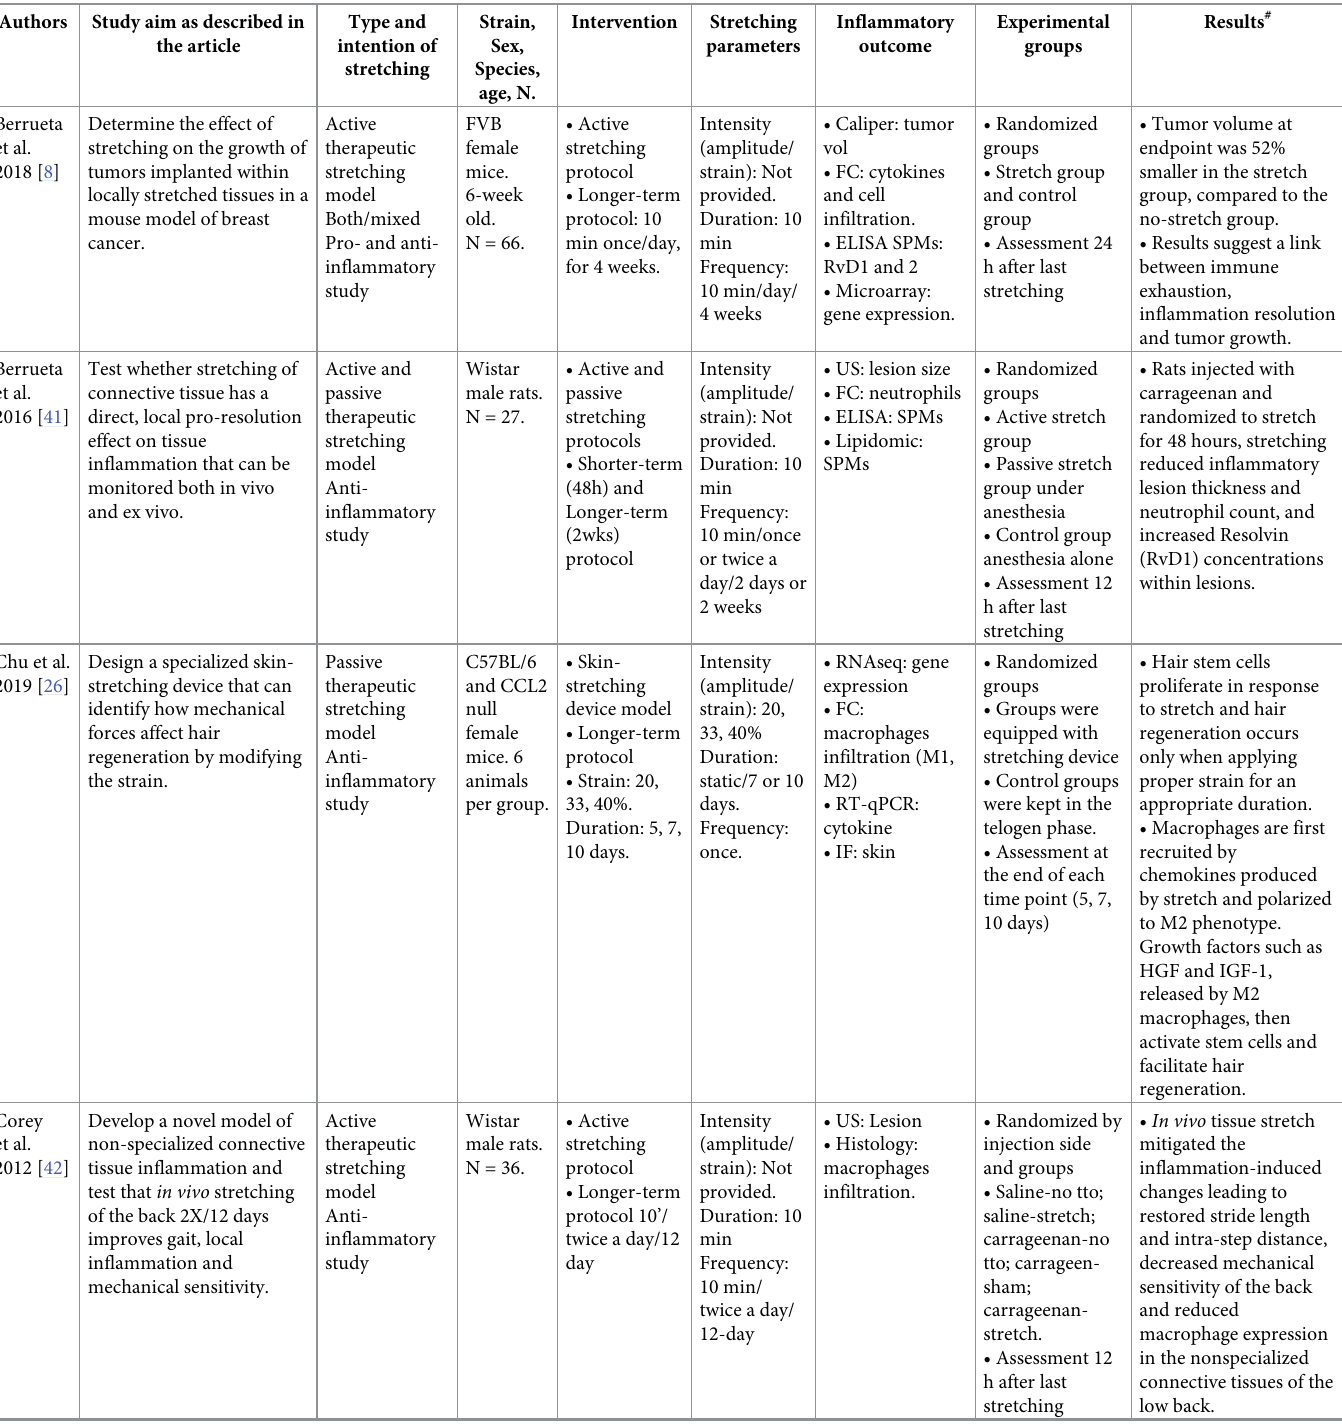
Table 4. Summary of effects of skin and surrounding connective tissue stretching on inflammatory markers in animal